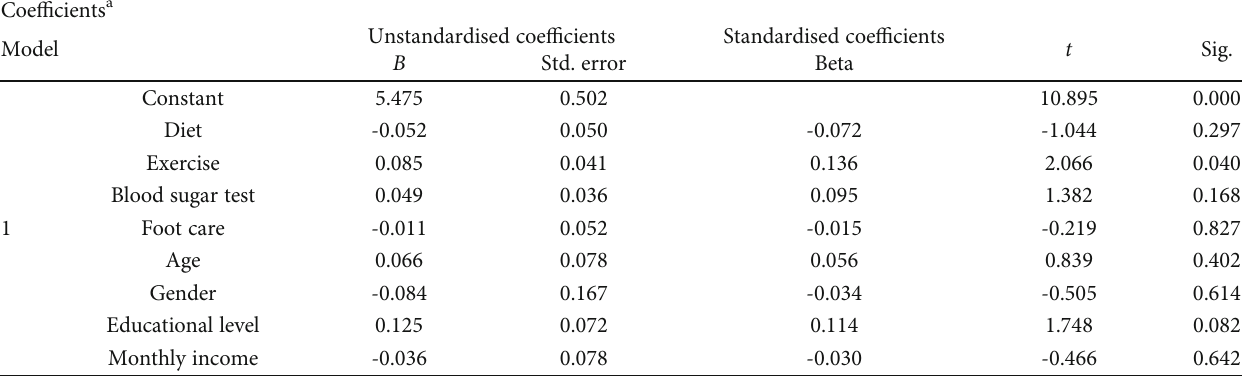
Table 9: Regression model coe ffi